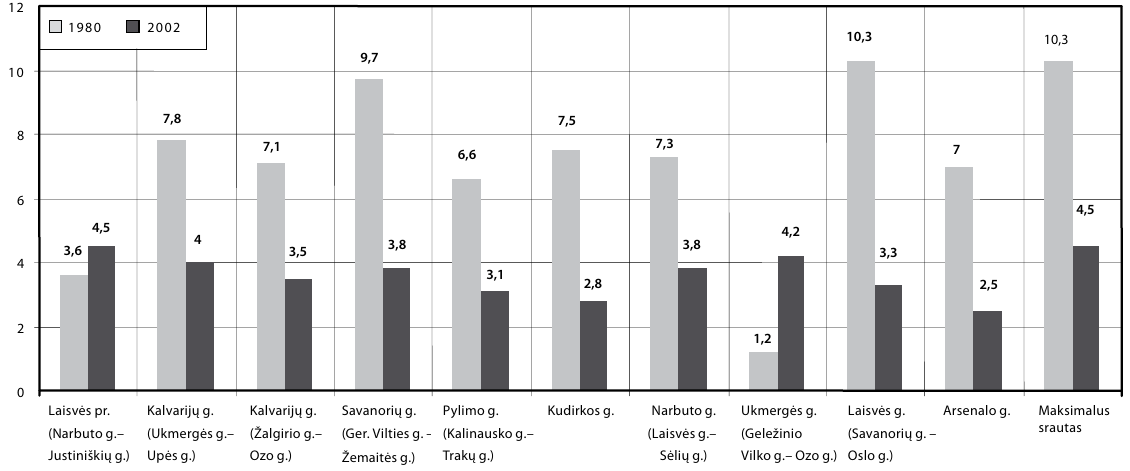
Fig. 1. Dynamic of maximum one-way passenger flows in Vilnius public transport system (thous.